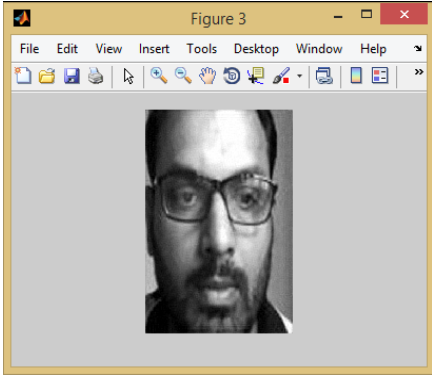
Figure 5. Real-time face detection with the processing time.